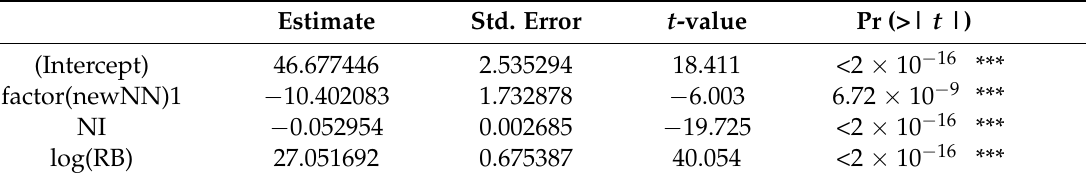
Table 5. Final Model (ANOVA table).